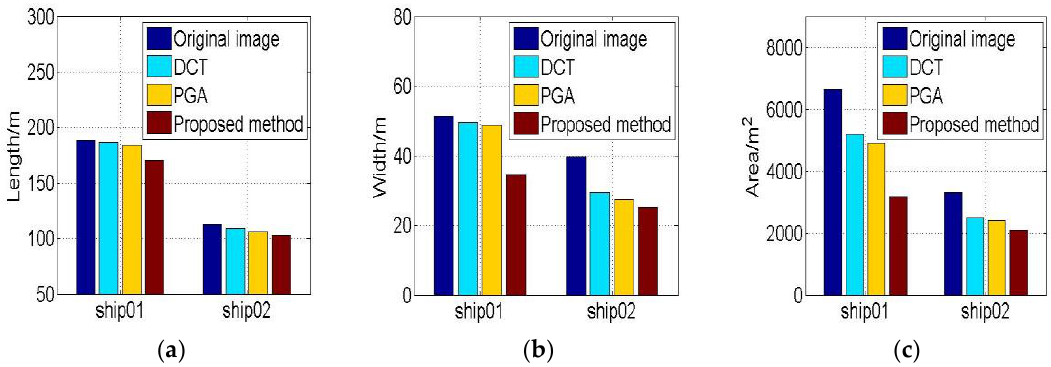
Figure 9. The geometrical features of refocusing ship01 and ship02. ( a ) Lengths of ships; ( b ) Widths of ships. ( c ) Areas of ships.